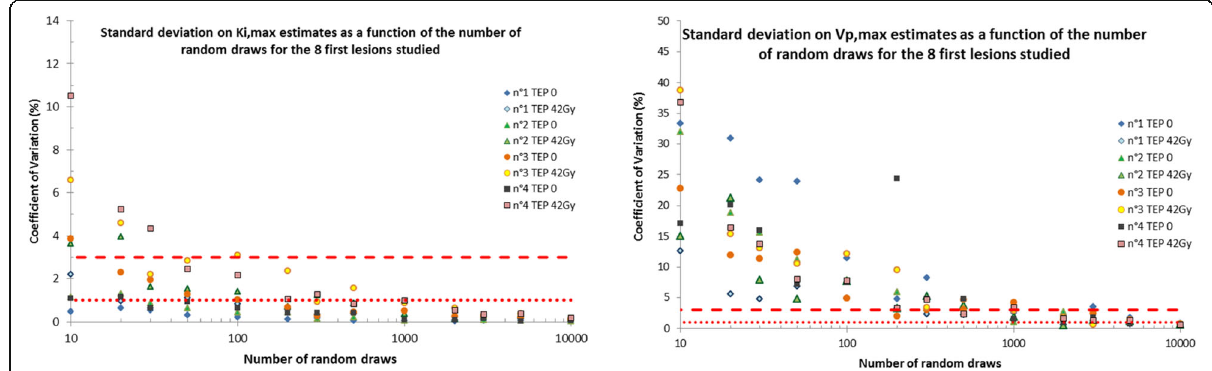
Fig. 4 Evaluation of the robustness of our proposed method; K i,max (left fig.) and V p,max (right fig.) estimates using 10 to 10,000 random draws for 8 lesions. Each calculation was repeated five times to derive the standard deviation on K i,max estimates. The coefficients of variation of 1% and 3% are represented by the dotted and the dashed lines